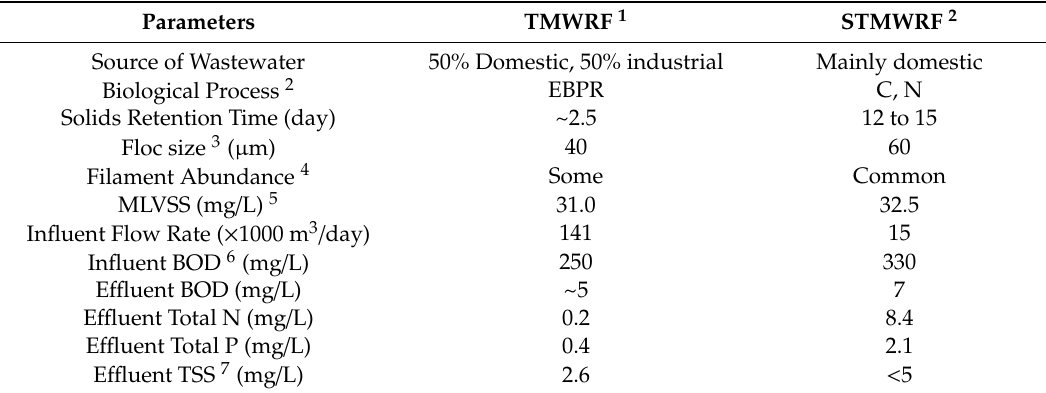
Table 1. Description of the two full-scale domestic water resource recovery facilities and characteristics of activated